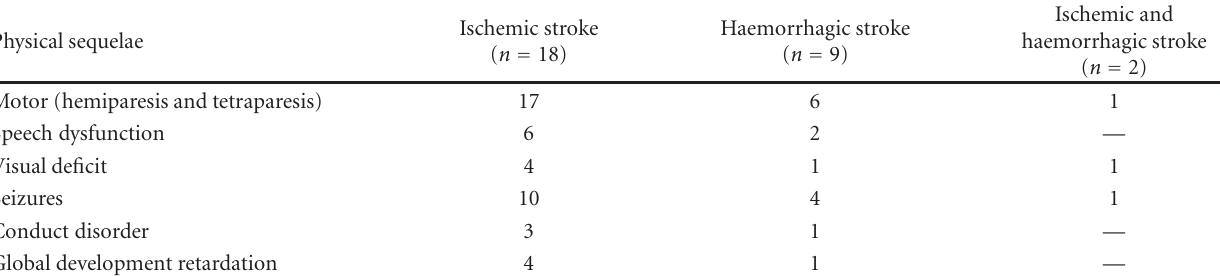
Table 2: Physical sequelae at